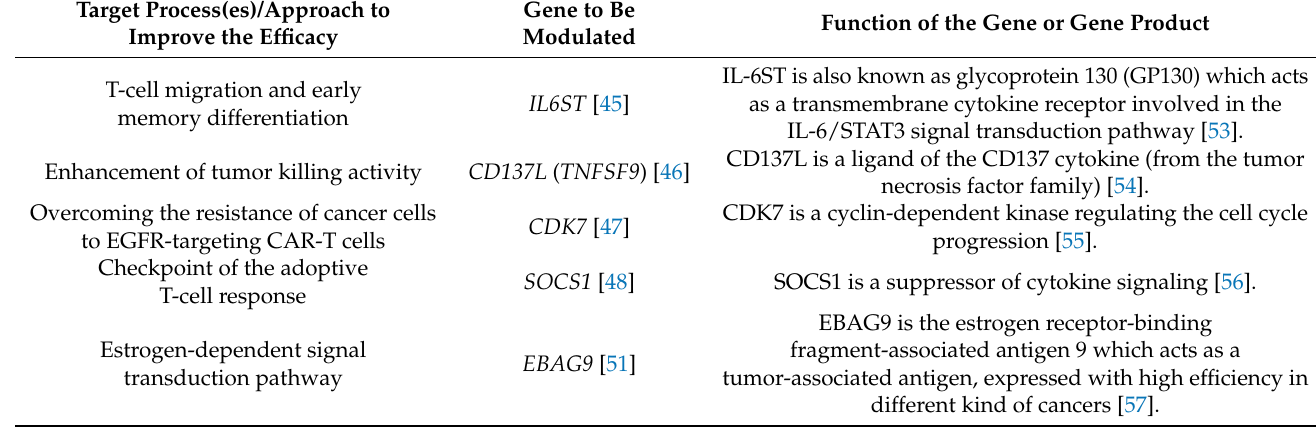
Table 3. Improving the efficacy of CAR-T-based therapies using transcriptomics to identify gene(s) to be